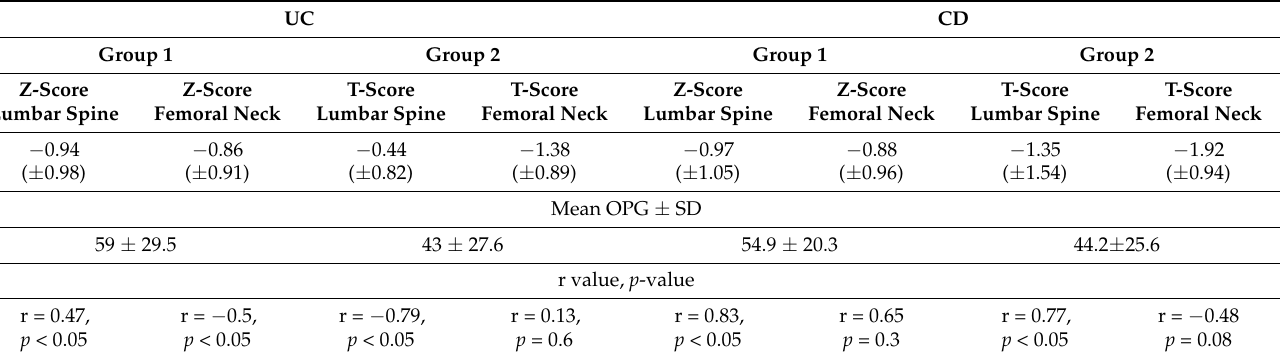
Table 4. Correlation between mean BMD T- and Z-scores ( ± SD) and mean OPG levels for UC and CD in both IBD